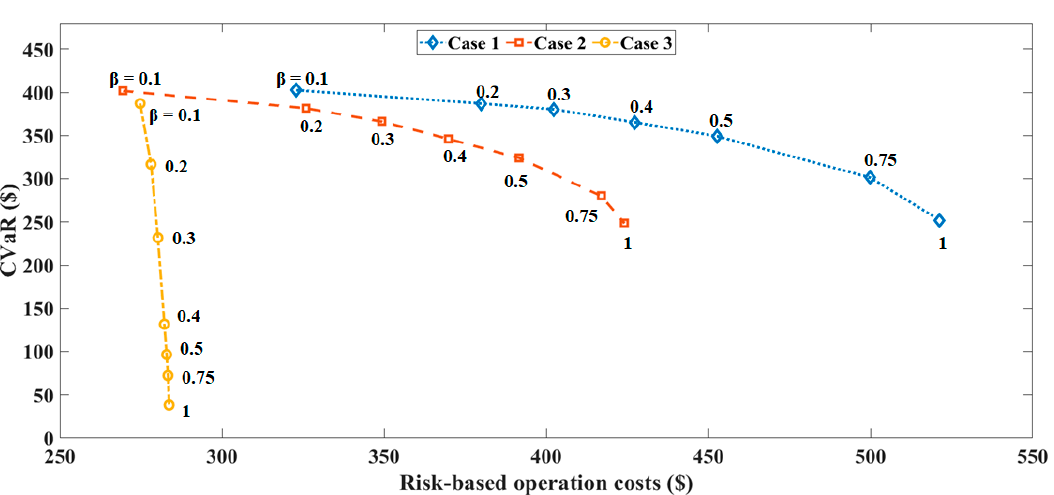
Figure 11. Optimal solution for each case.